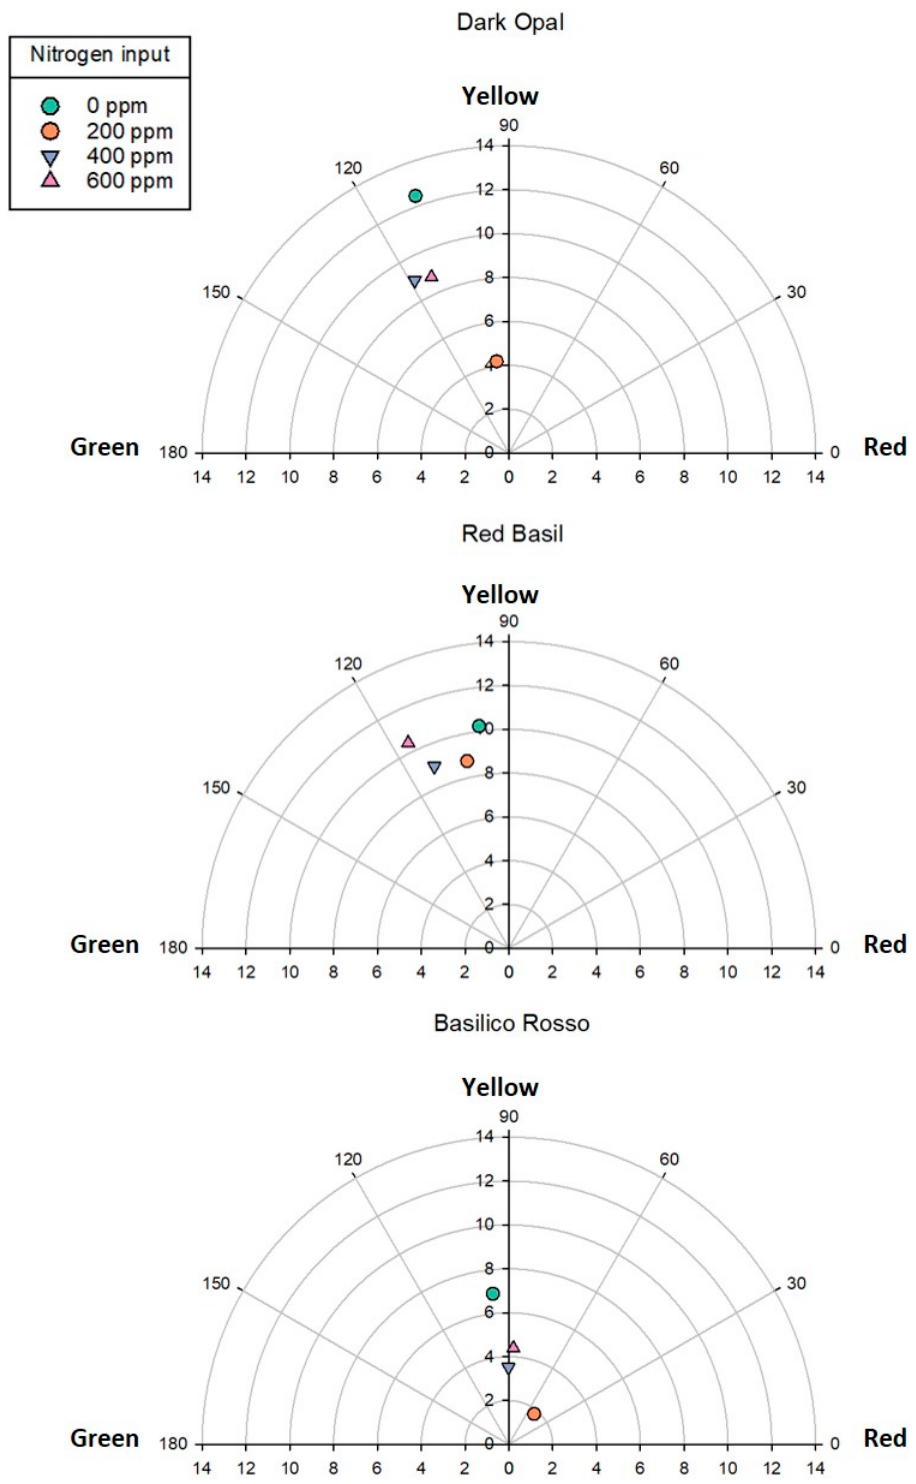
Figure 3. Chroma-hue plot of Dark Opal, Red Basil, and Basilico Rosso leaves in response to Figure 3. Chroma ‐ hue plot of Dark Opal, Red Basil, and Basilico Rosso leaves in response to nitrogen nitrogen input.